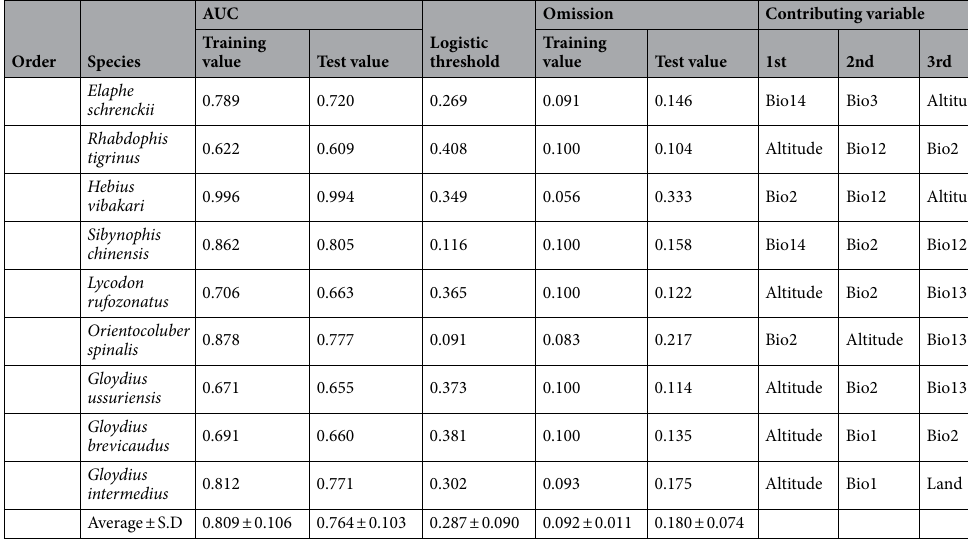
Table 2. Summary of species distribution models for the 19 amphibian and 20 reptilian species using Maxent modeling.